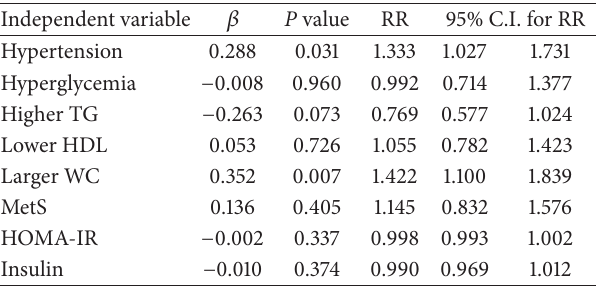
Table 2: The results of follow-up for participants without thyroid Table 3: Univariate binary logistic regression analysis: dependent diseases in 2009. variable is thyroid nodule in 2012, and independent variables are the status of the metabolic components, Mets, HOMA-IR, and Insulin Male Female in 2009. (Method: Enter). Results in 2012 𝑛 % 𝑛 % Independent variable Normal 417 54.02 149 51.56 TN 333 43.13 123 42.56 Cancer 5 0.65